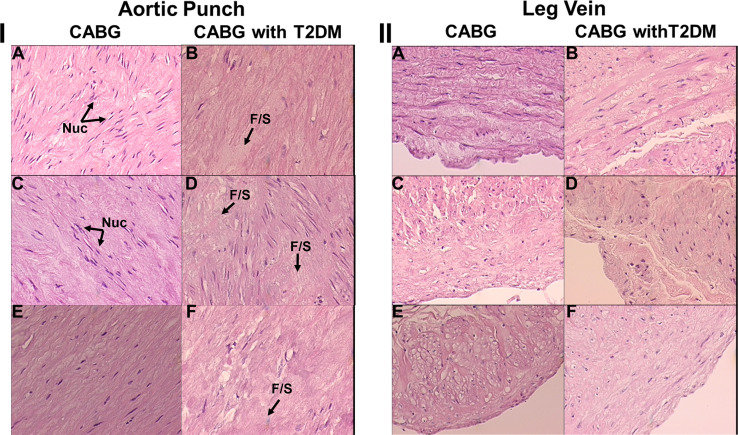
H & E histology of aortic punch (I) and leg vein (II) from patients with and without T2DM undergoing CABG procedure.The noted features in panel I are nuclei (Nuc) and fibrosis/scarring (F/S). 20x magnification.